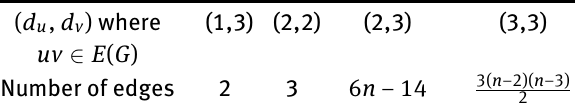
Table 1: The edge partition of the graph O P